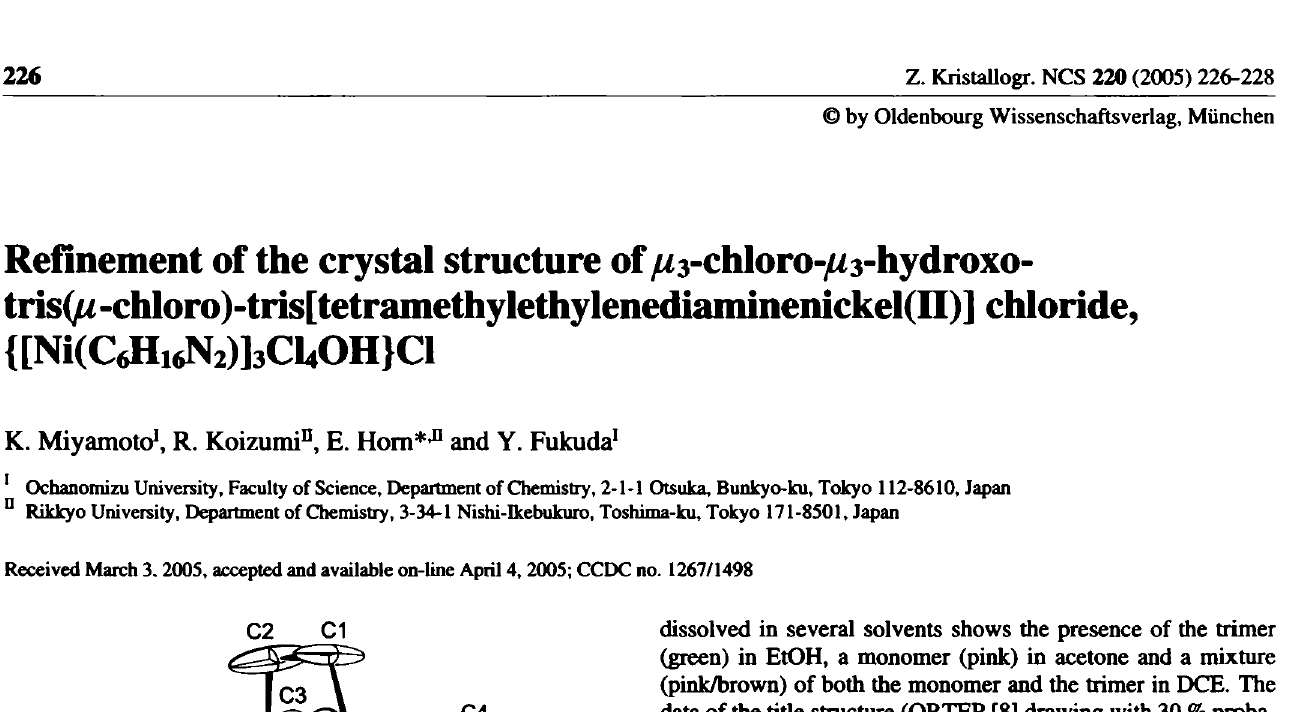
Table 1. Data collection and handling.